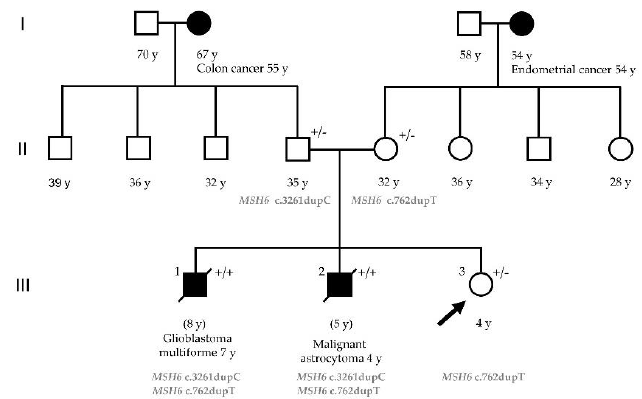
Figure 1. Pedigree of the family with biallelic MSH6 mutations. The arrow indicates the proband. Filled symbols indicate affected subject; open symbols unaffected subjects. The age at tumor onset is shown with the tumor type. +/− = MSH6 monoallelic mutation carrier (Lynch syndrome); +/+ = MSH6 biallelic mutation carrier (CMMRD).